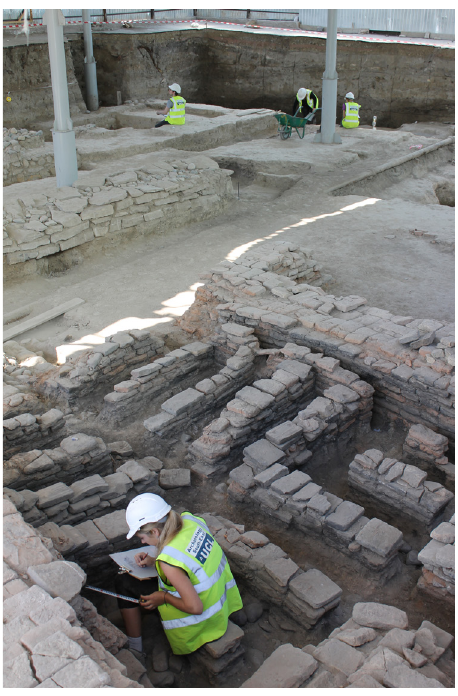
hamam bathhouse (Building